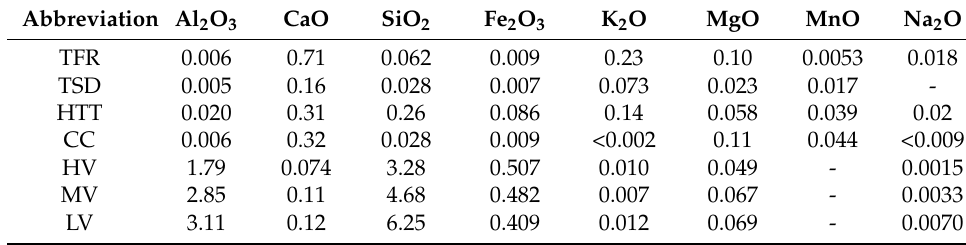
Table 3. Oxide content in the carbonaceous materials (wt%, dry